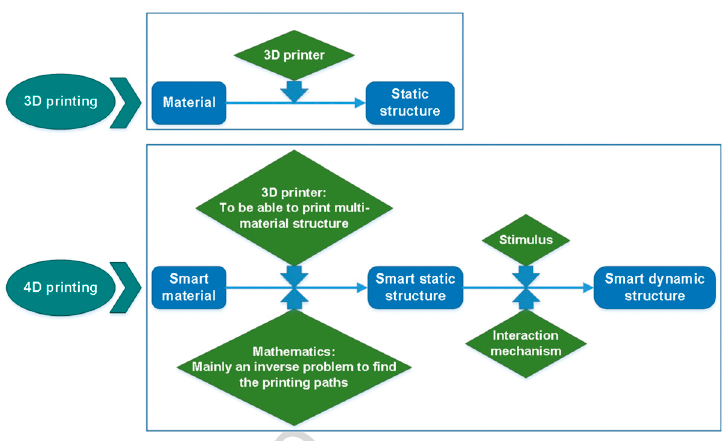
Figure 2. Comparison of the process for 3D printing and the process for 4D printing. Copyright (2017), with permission from Elsevier.